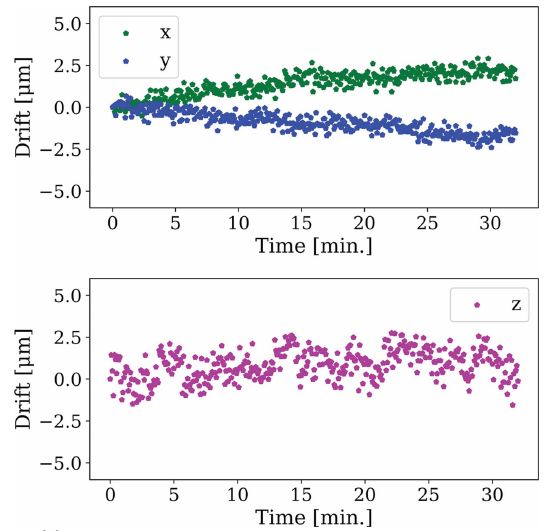
Figure 11 Translational detector parameter drifts in the x , y and z directions measured over a 32 min scan using X-ray diffraction geometry calibration routines available in DAWN .